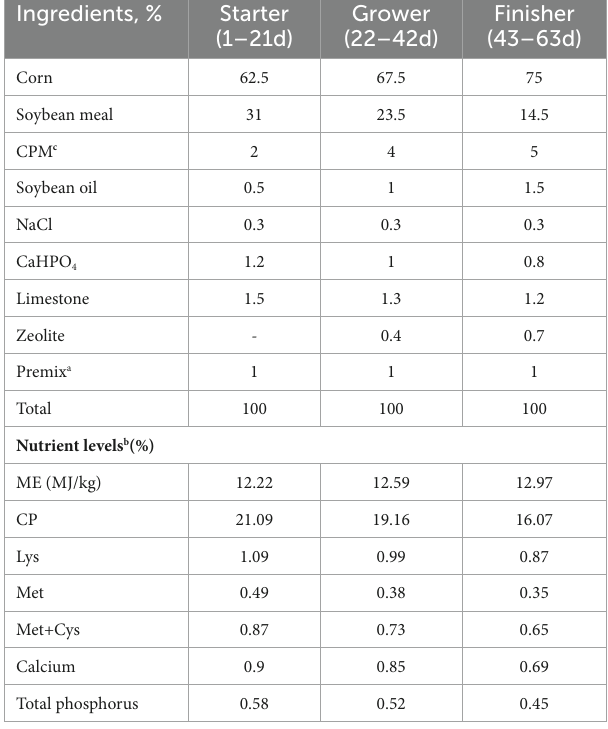
TABLE 1 Composition and nutrient level of the basal diet (% as fed basis). Ingredients,